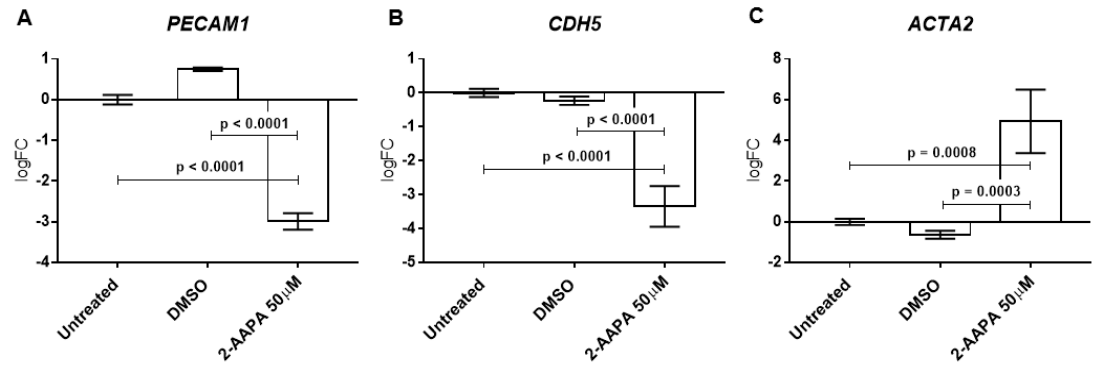
Figure 4. Protein S-glutathionylation and endothelial-to-mesenchymal transition. Quantitative Polymerase Chain Reaction (qPCR) of the gene encoding endothelial markers ( A ) CD31, ( B ) VE-cadherin and mesenchymal marker ( C ) ACTA2 after 4 h of 2-AAPA (50 µ M) treatment and 48 h of recovery ( n = 3). qPCR data are expressed as log2 fold change (logFC) in comparison to untreated cells.